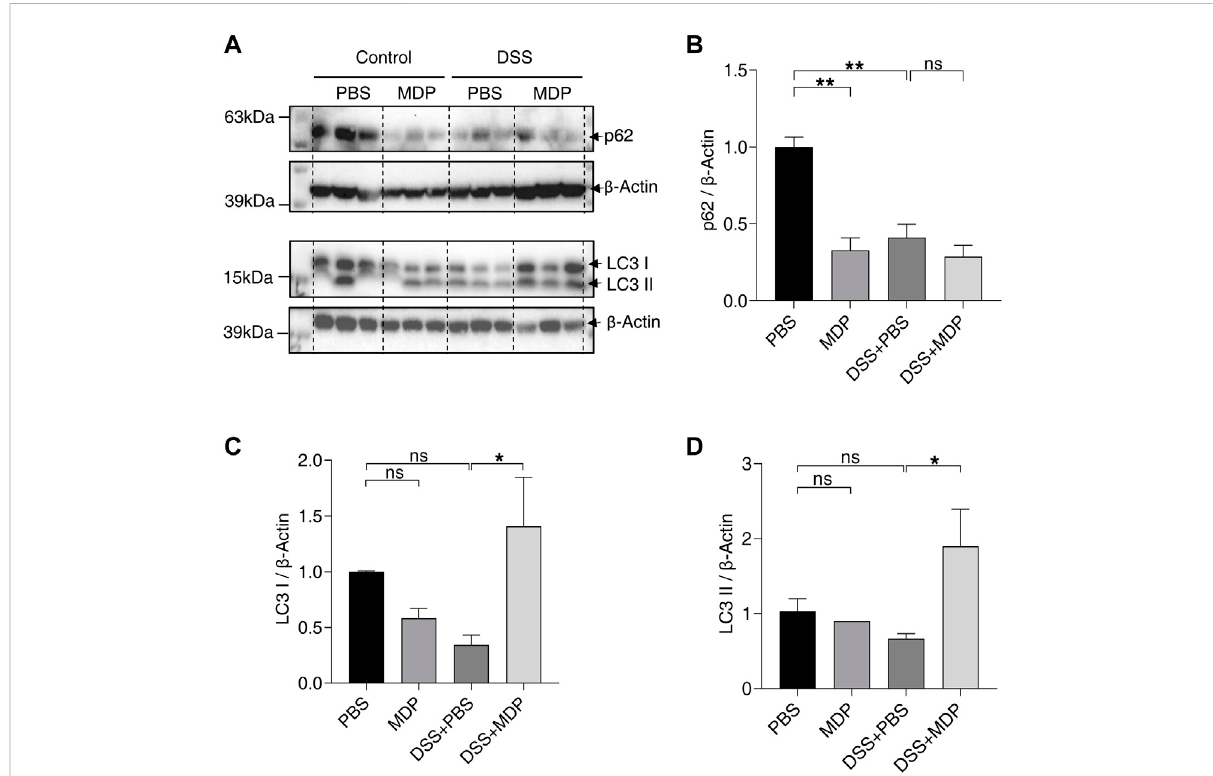
FIGURE 5 MDP activates autophagy in colon of DSS-induced mice. (A) Western blotting analysis for p62, LC3 I, and LC3 II with β -Actin as the internal standardproteininthecolonofPBS,MDP,DSS+PBS,andDSS+MDPgroupmice.Representativeimagesofthreeduplicatesamplesoftheimmune blottingwereshown. (B – D) Quanti fi cationoftherelativeexpressionofp62,LC3IandLC3IIinpanel (A) byImageJ,respectively.Datawereexpressed as mean ± SEM. * p < 0.05, ** p < 0.01, ns, not signi fi cant, One-way